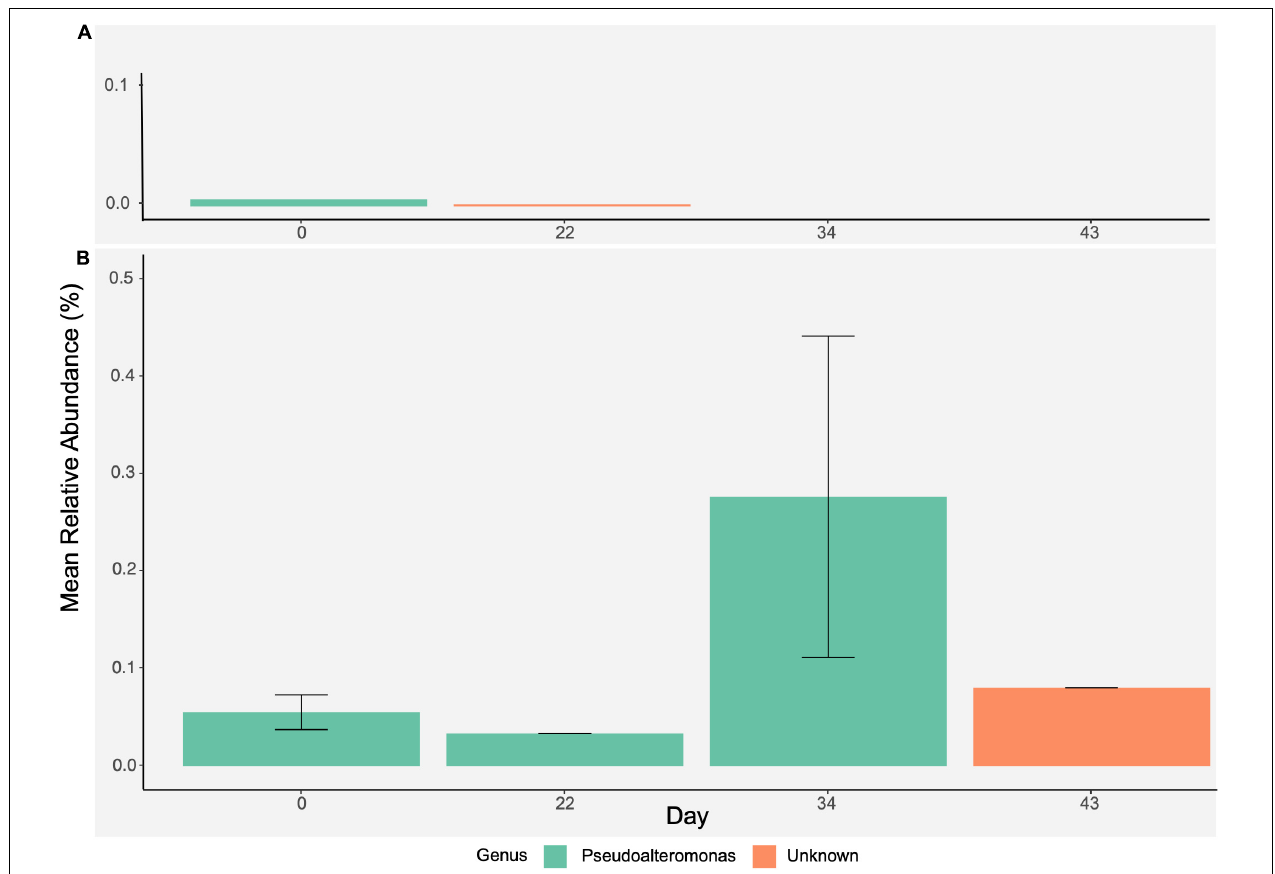
FIGURE 6 | Further analysis of order Vibrionales. Bar plots represent mean relative abundance ( ± SE) of Vibrionales over time by (A) control and (B) heat stress treatments and show a breakdown of genera present within